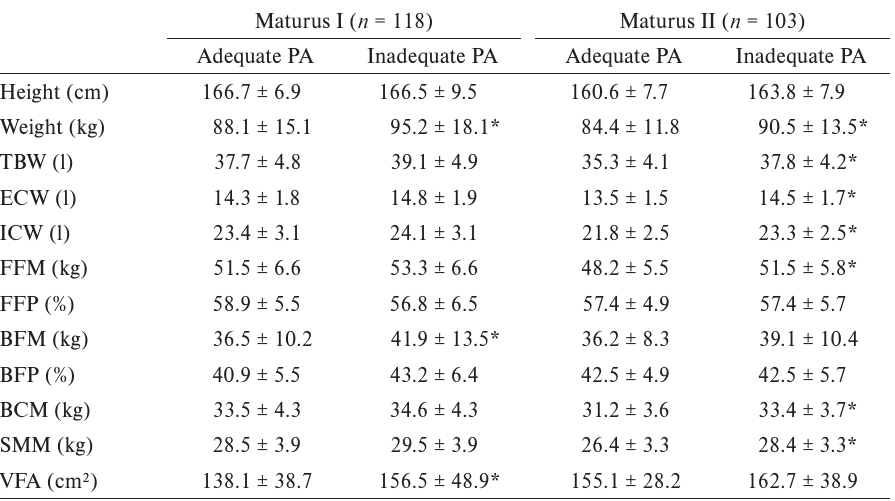
Selected somatic characteristics in relation to the age and physical activity Maturus I ( n = 118) Maturus II ( n = 103) Adequate PA Inadequate PA Adequate PA Inadequate